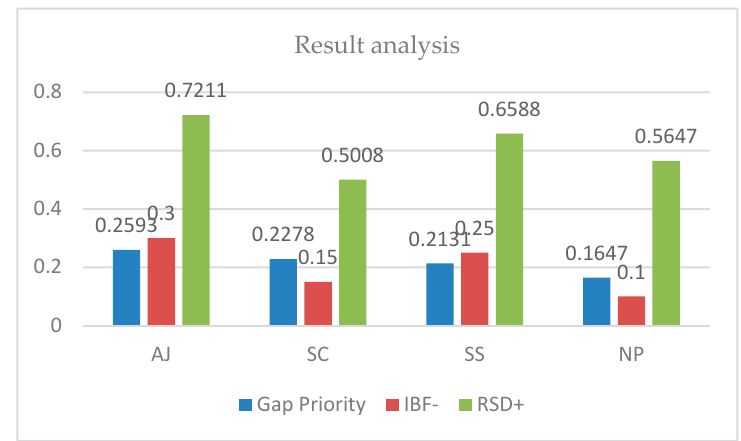
Figure 7. Result analysis.